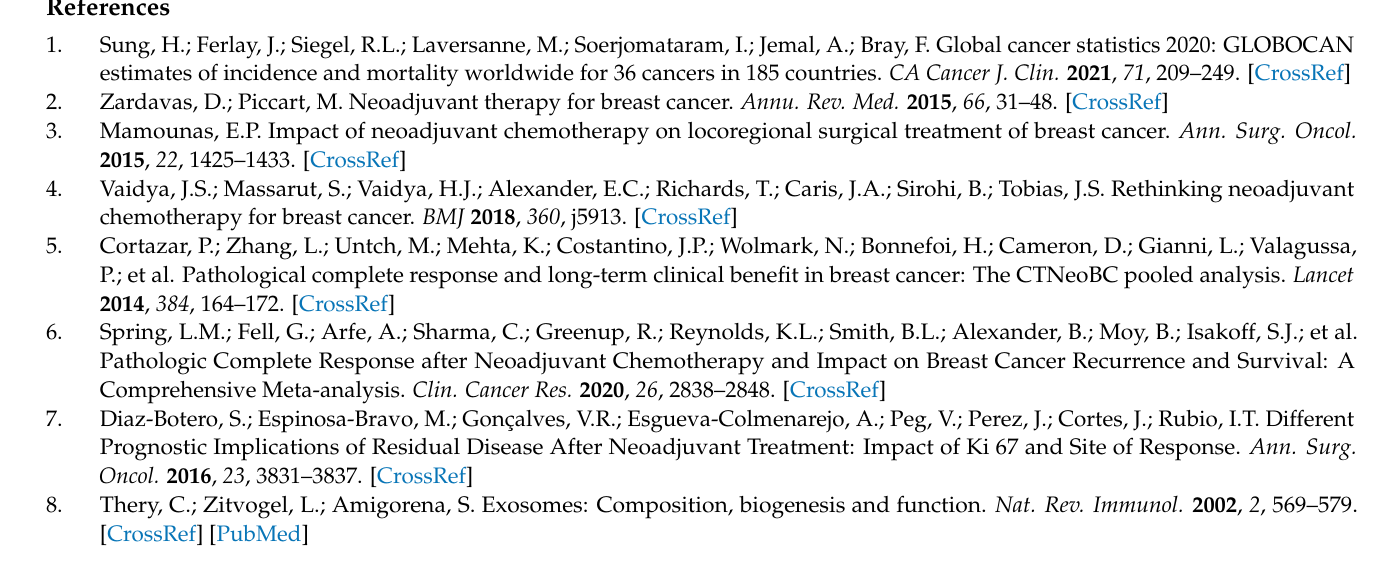
Figure S2: Uncut blots for Figure 1E, Figure S3: Uncut blots for Figure S1, Table S1: Full name for each target in the ProcartaPlex immune-related